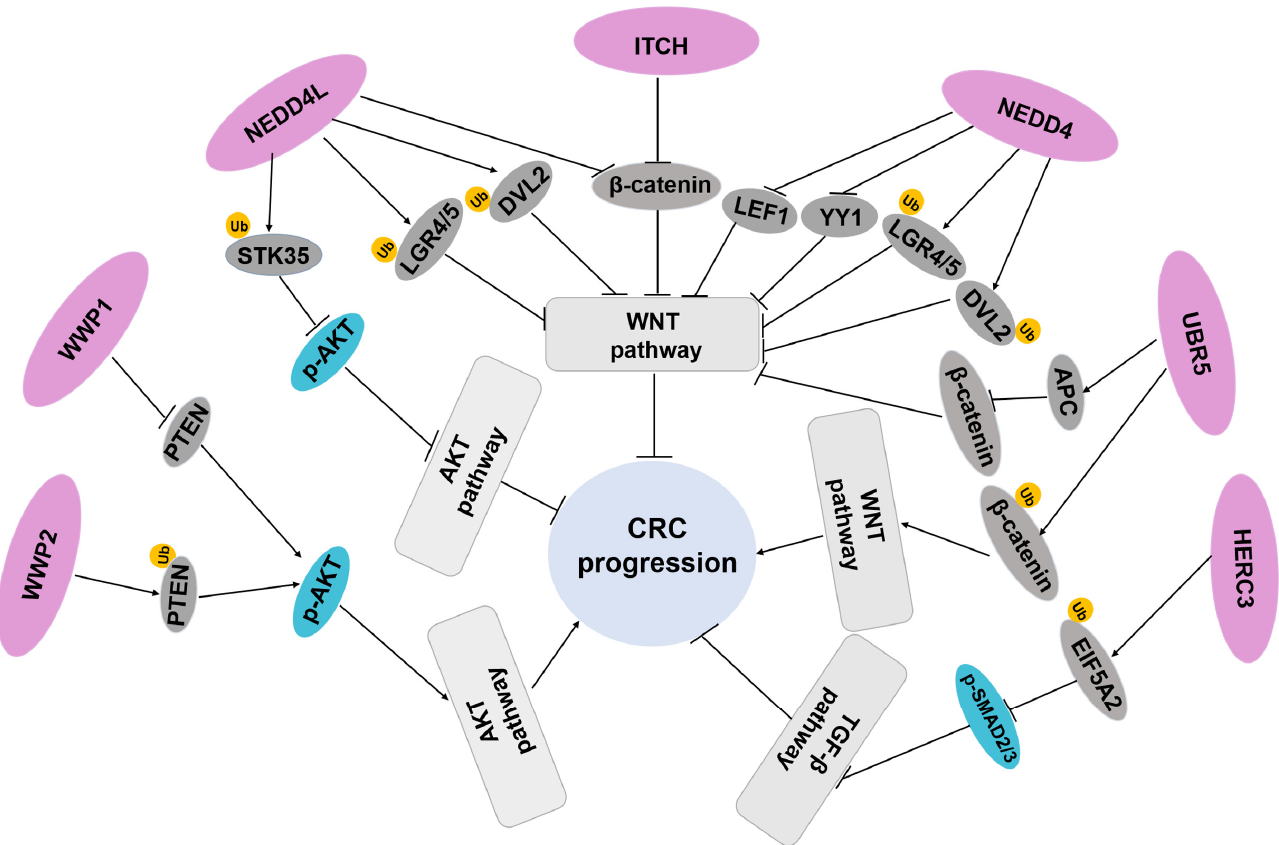
Figure 2. Regulation of important signaling pathways by HECT E3 ligases in CRC. NEDD4 and NEDD4L mediate RSPO receptor LGR5 and DVL2 lysosomal and proteasomal degradation, resulting in inactivation of WNT/ β -catenin signaling pathway and inhibition of susceptibility and progression of colorectal tumors. NEDD4 also exerts tumor-suppressive functions by downregulating the protein level of LEF1 and YY1. NEDD4L causes ubiquitination and degradation of STK35 and block AKT pathway to inhibit CRC progression. ITCH represses CRC tumorigenesis by downregulating the protein level of β -catenin, and WWP1 drives CRC progression by activating AKT signaling pathway. WWP2 executes its regulation of the AKT signaling pathway through its E3 ligase activity. HERC3 promotes ubiquitination and degradation EIF5A2 to inactivate the TGF- β /Smad2/3 signaling in CRC development. UBR5 can mediate nonproteolytic ubiquitination of β -catenin to activate WNT pathway in CRC, and UBR5 also inhibits the Wnt/ β -catenin pathway by upregulating APC.